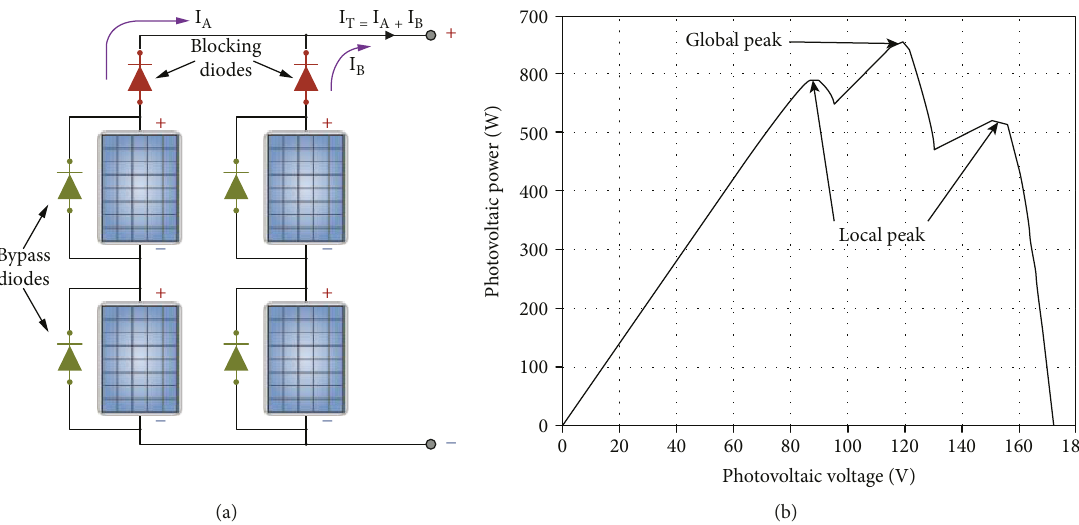
Figure 9: (a) Bypass and blocking diode application. (b) Power-voltage characteristic curve of six PV modules connected in series under partially shaded conditions featuring multiple peaks.